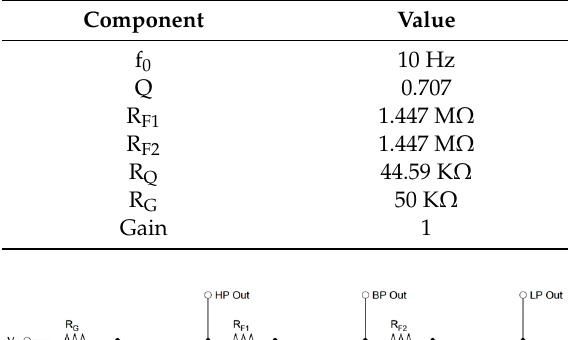
Figure 3. High-pass filter of 60 Hz with the UAF42. Table 2. Values obtained for the high-pass filter of 10 Hz with the Filter 42 program.